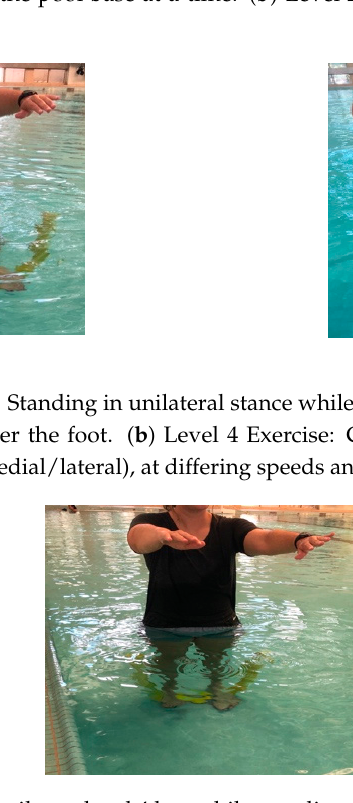
Figure 3. Level 5 Exercise: Similar to level 4 but while standing on noodle, shifting base of support, while opening/closing eyes, adding cognitive tasks. Table 1. An example of various levels of hydrotherapy-based balance training exercises for geriatric populations based on adaptations from Oddson et al. [28,29].